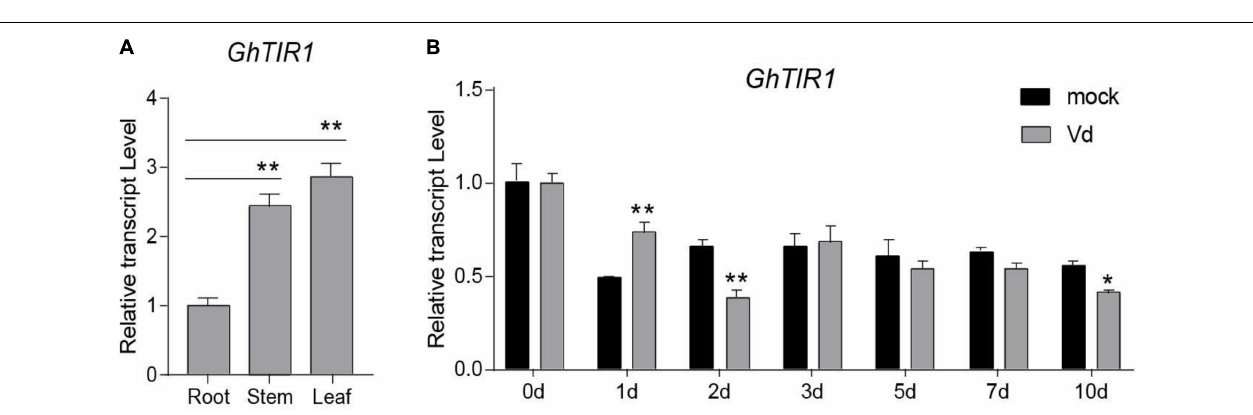
FIGURE 2 | Tissue expression profile and pathogen-induced expression profile of GhTIR1. (A) The tissue expression profile of GhTIR1 . (B) The expression profile of GhTIR1 in plants inoculated with Verticillium dahliae . GhUB-7 was used as a reference gene. The error bars indicate the SD of three biological replicates. Statistical significance was determined by Student’s t -test, as compared with the mock treatment, * P < 0.05, ** P <